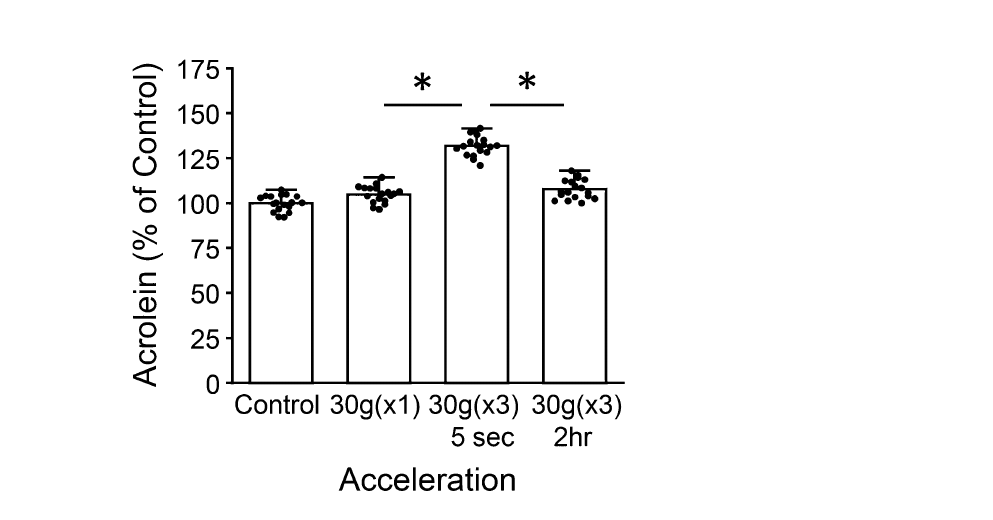
Figure 5. Increased inter-impact periods mitigate post-injury elevation of acrolein adducts. A 2 h time period was introduced between series of multiple impacts (multiple-sequential impacts), and average intensity measurements from ICC for acrolein-Lys adducts were performed at 24 h post-injury. Networks received three 30 g impacts in rapid succession (termed 30 g(×3)5 s) and were compared to networks that were exposed to three 30 g impacts separated by 2 h impact-intervals (termed 30 g(×3)2 h) and non-impact controls. A single 30 g impact-network is included for comparison. Interestingly, these inter impact intervals significantly decreased acrolein production when compared to 30 g(×3)5 s networks. Staining intensity is shown as percent control values ± SD (n = 18). One-way ANOVA and subsequent Scheffe post hoc analysis were used to determine significance: *p <